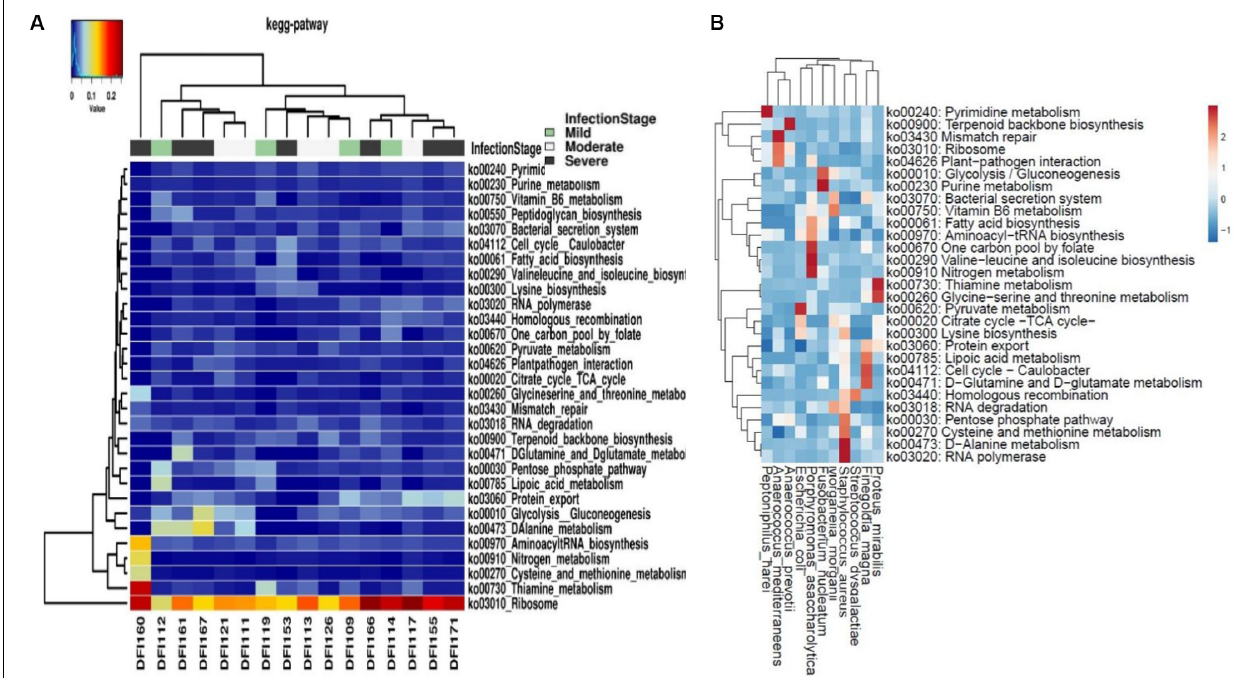
FIGURE 5 | (A) Top 30 metabolic pathways predicted using the KEGG and visualized in Calypso. (B) Heatmap of KEGG pathways in highly transcriptionally active bacteria.